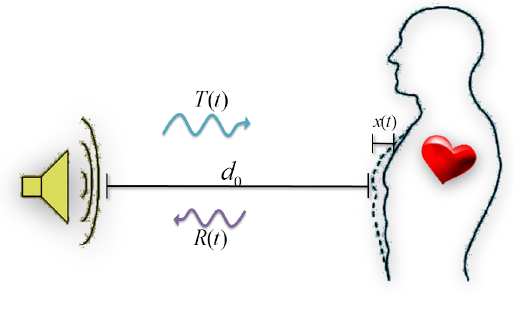
Figure 1: Scattering scenario: a human being is probed by a CW radio